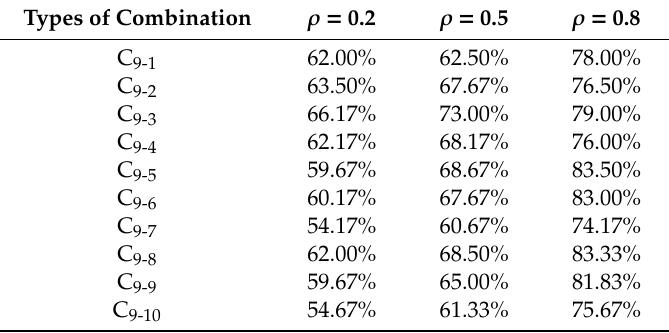
Table 9. MARS Identification results, AIR -MARS {null}, for ten combinations of faults of an MNP 9 .